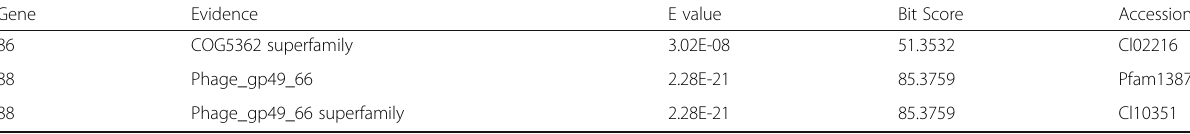
Table 6 Delftia phage RG 2014 annotation using conserved domain database* (Continued)